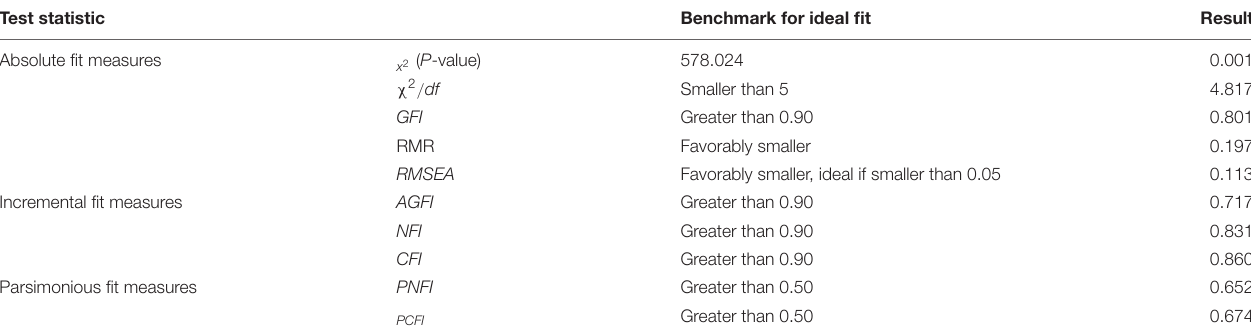
TABLE 4 | Fit indicators of the conceptual framework.